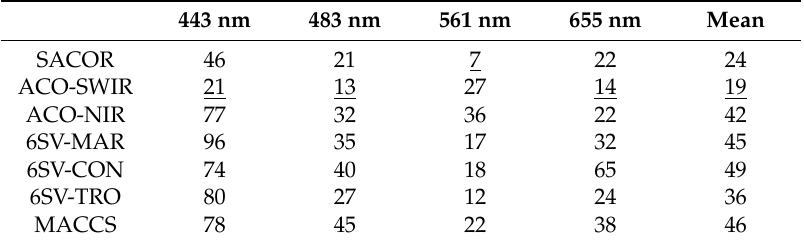
Table 4. Relative error (%) between satellite-derived and RSR-adjusted in-situ ρ w (N = 8), which were computed for the four OLI visible bands. The underlined value for each channel is associated with the lowest error. 443 nm 483 nm 561 nm 655 nm